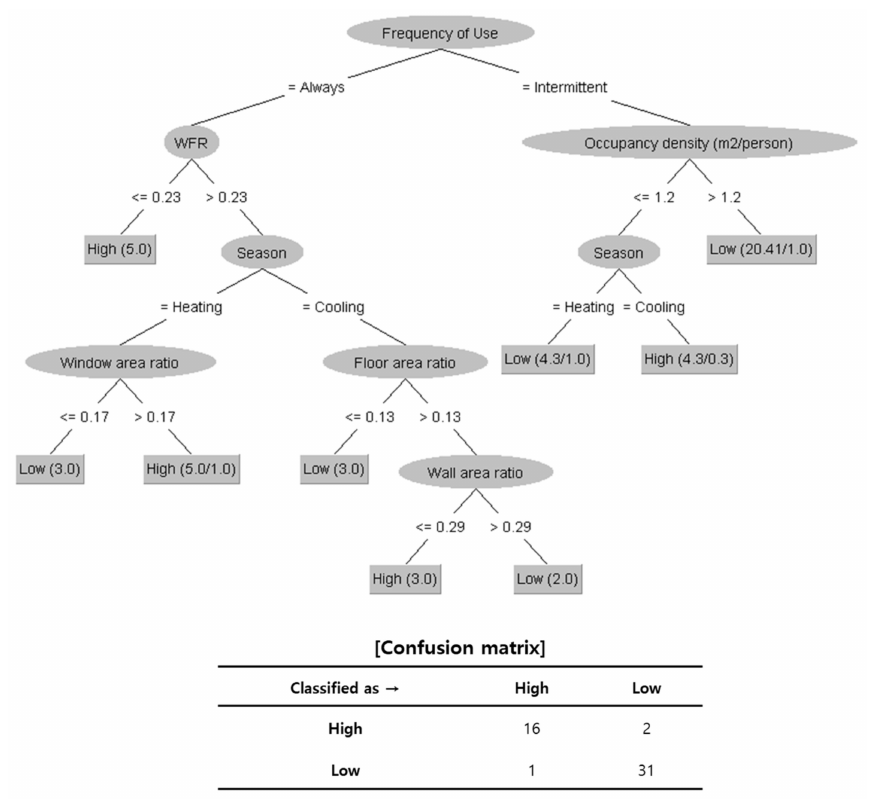
Figure 4. Decision tree based on the building and internal design